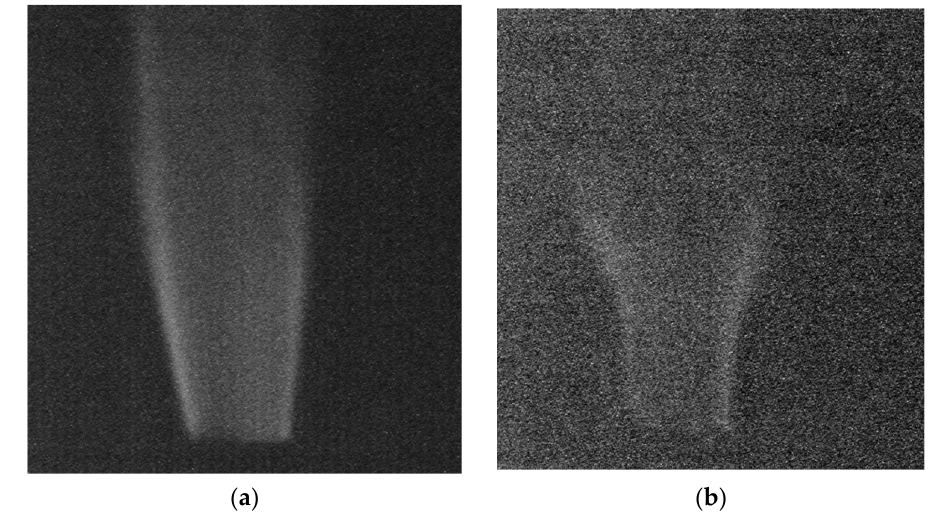
Figure 10. UV images of hydrogen gas generated by a rolling shutter mode ( a ) and by a global shutter mode ( b ).